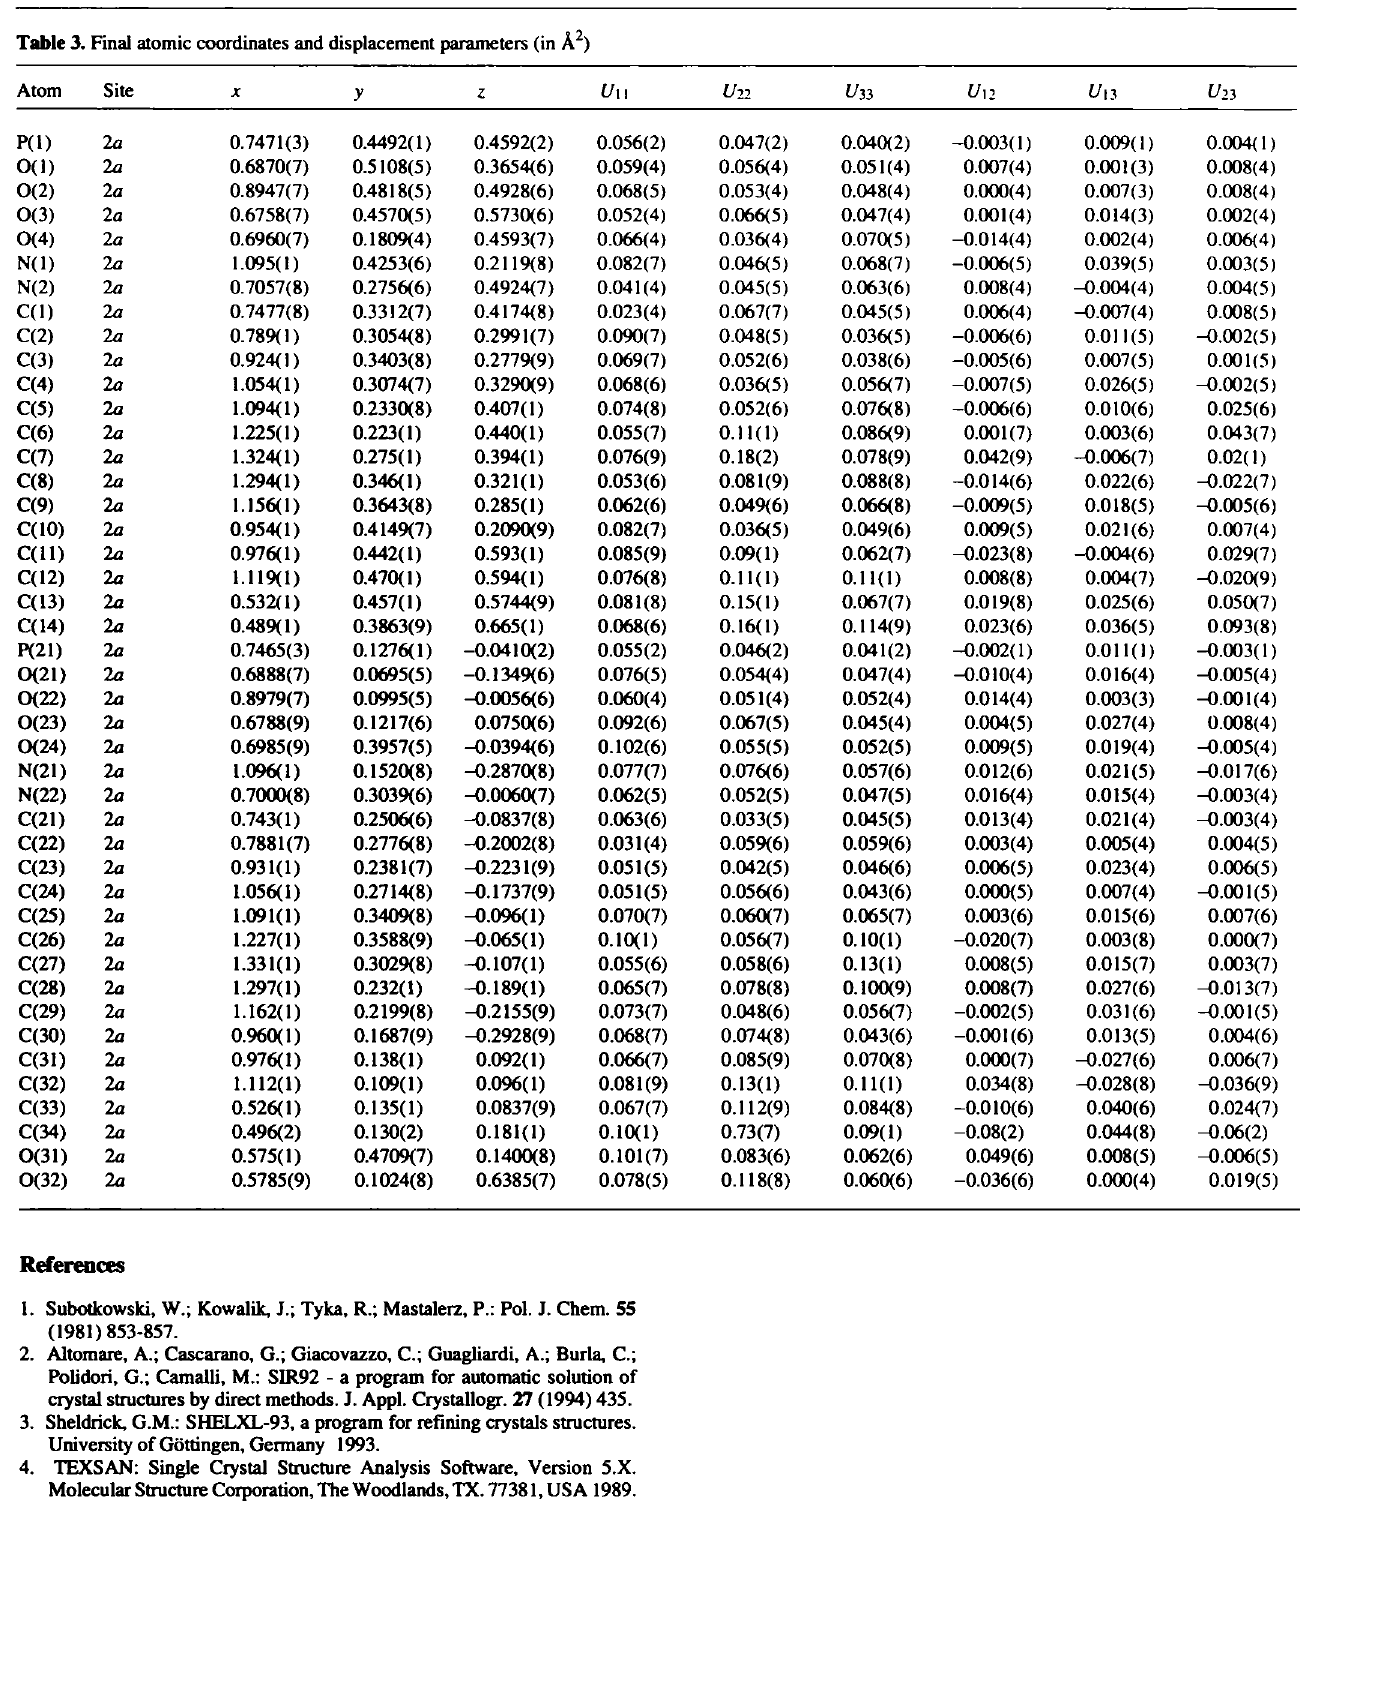
Table 3. Final atomic coordinates and displacement parameters (in